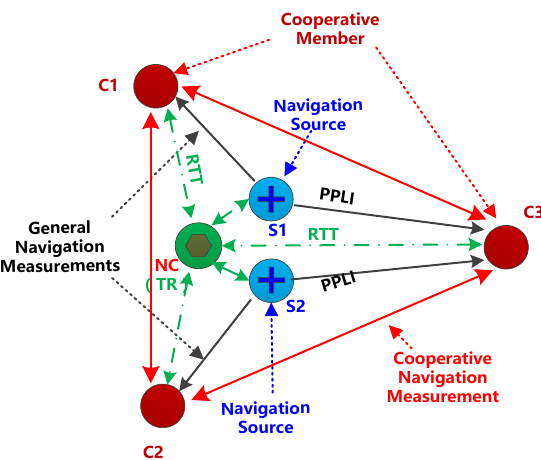
Figure 3. Cooperative navigation method.